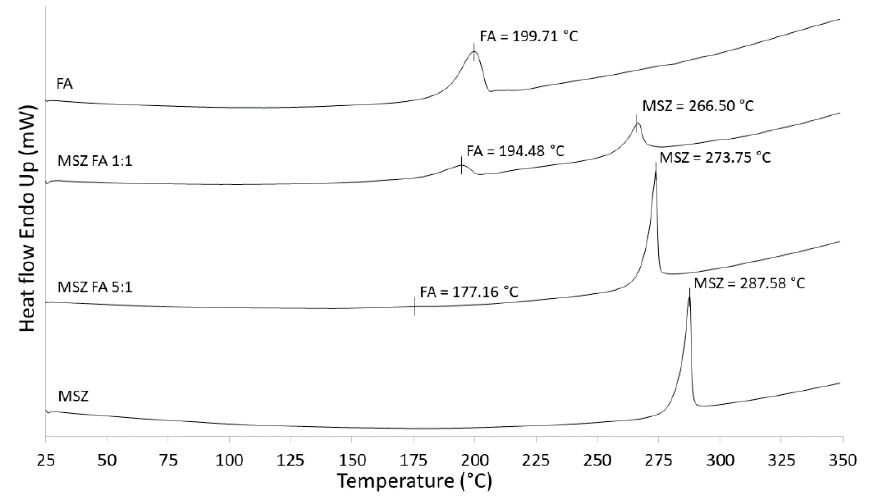
Figure 2. Differential scanning calorimetry (DSC ) curves of MSZ, FA and the prepared blends.